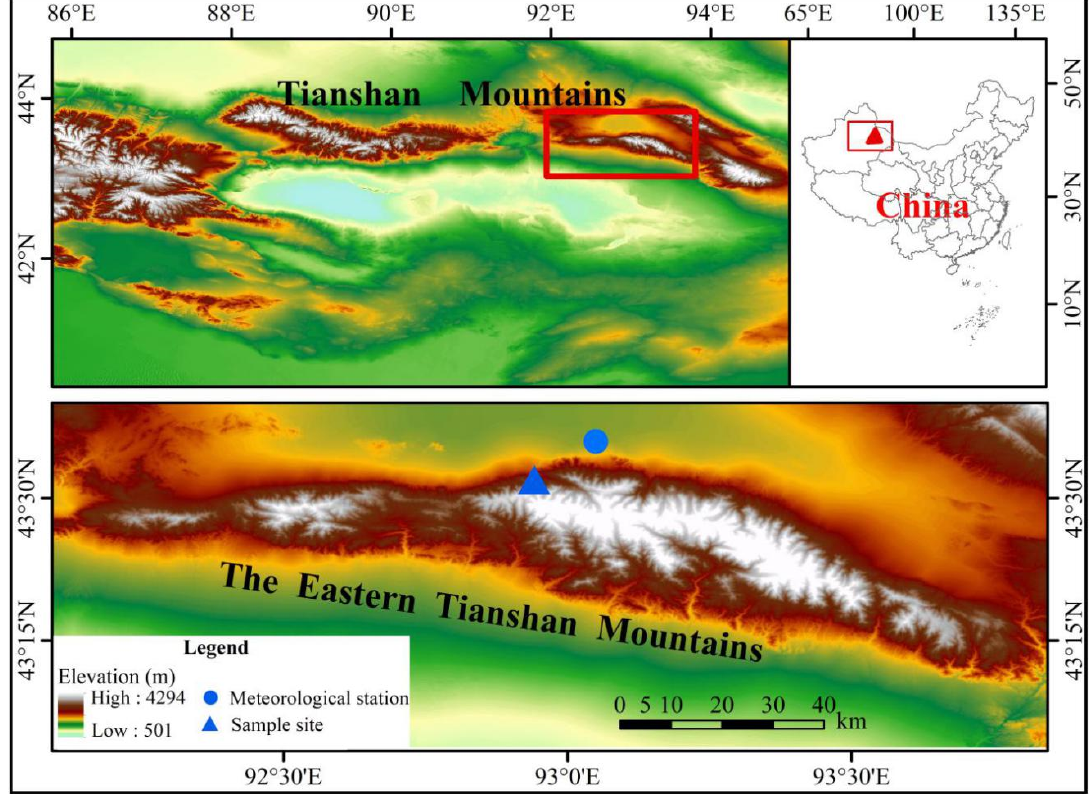
Figure 1. Location of the sampling site and the nearest meteorological station (Barkol meteorological station).